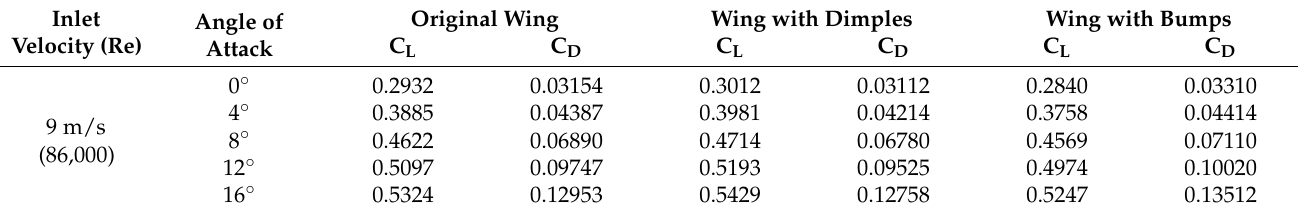
Table 7. Experimental lift and drag coefficients for each wing configuration.